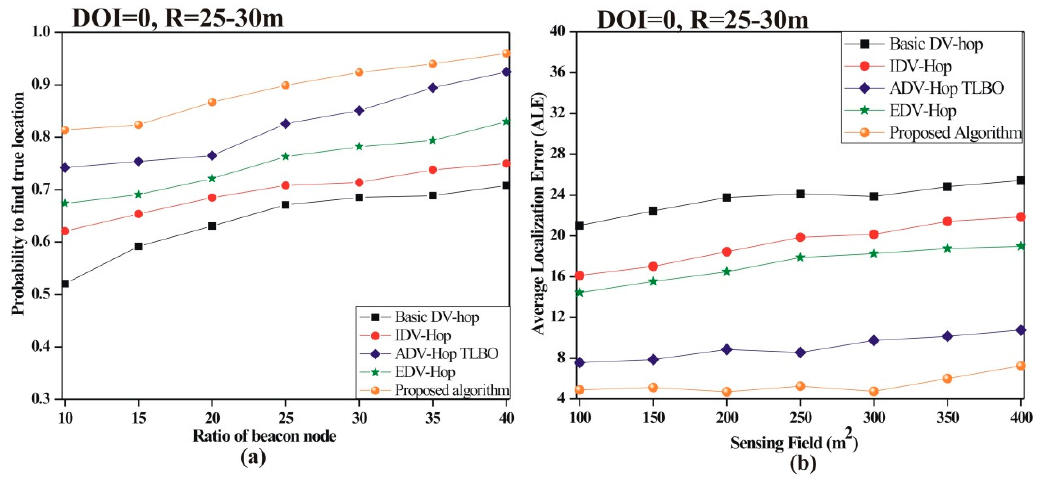
Figure 8. ( a ) Probability of finding the true location; ( b ) impact of the sensing field on ALE.